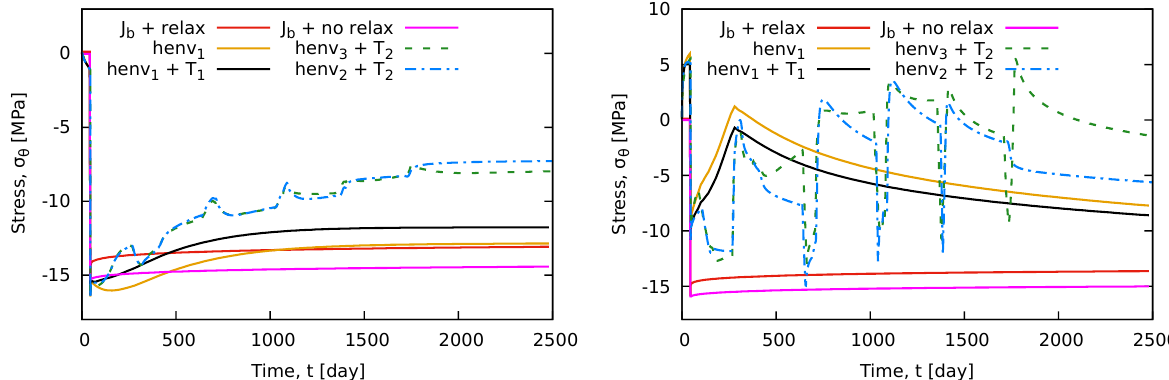
Figure 4. Evolution of hoop stress σ wall.